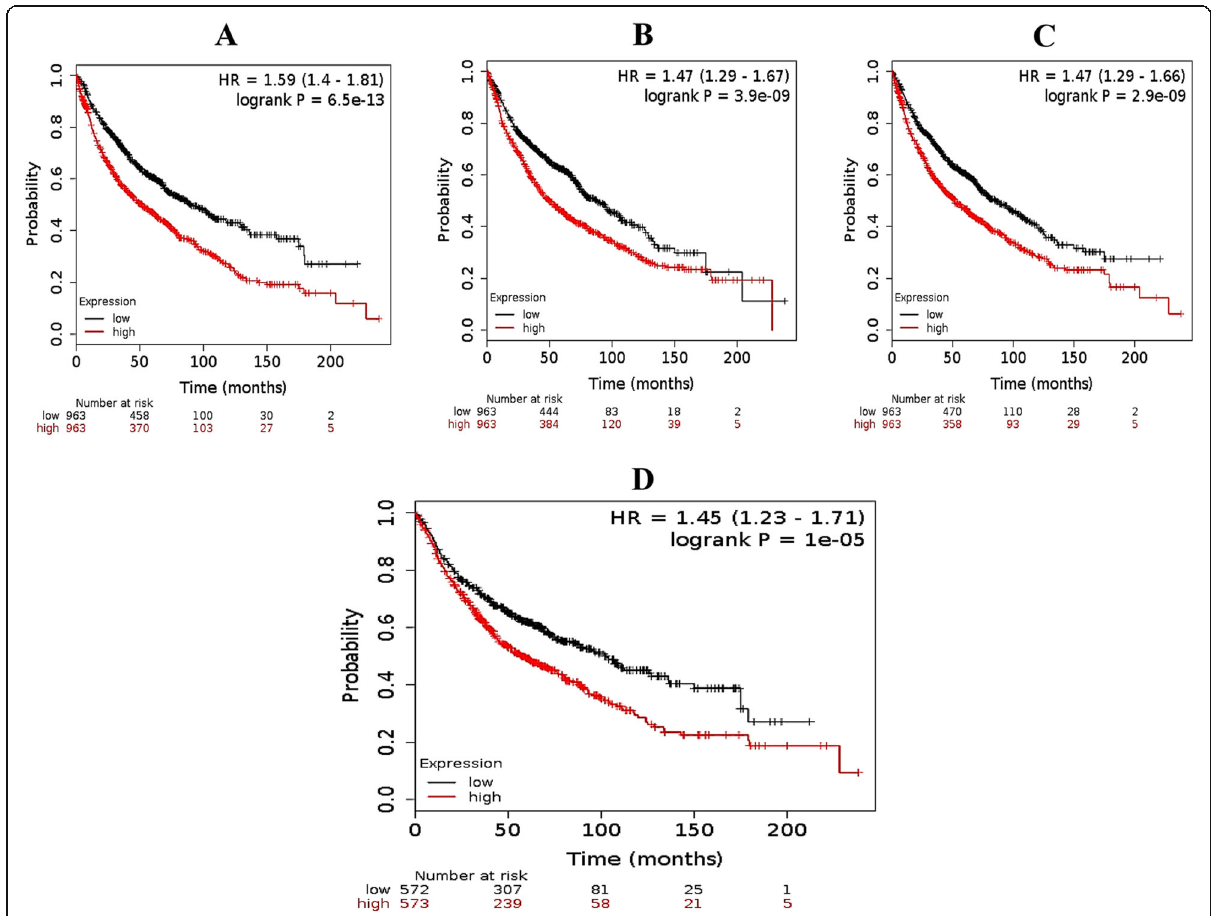
Fig. 4 Overall survival analysis diagram. a SFN, HR = 1.59; b DSP, HR = 1.47; c PHGDH, HR = 1.47; d overall mean of hub genes, HR =